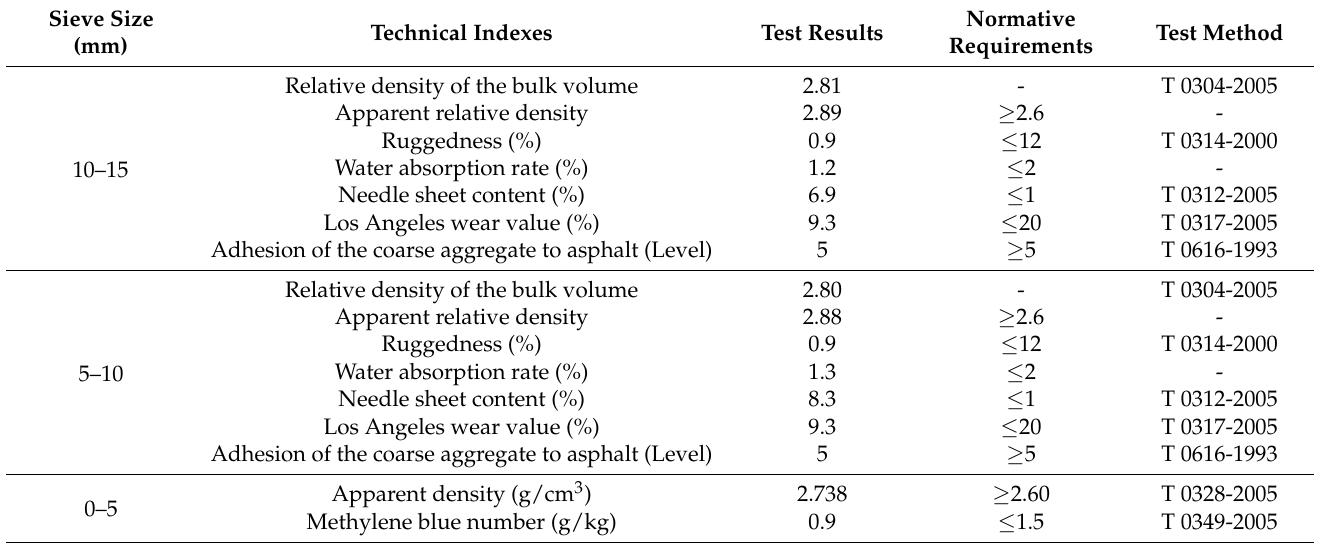
Table 1. Technical indexes of the aggregate.